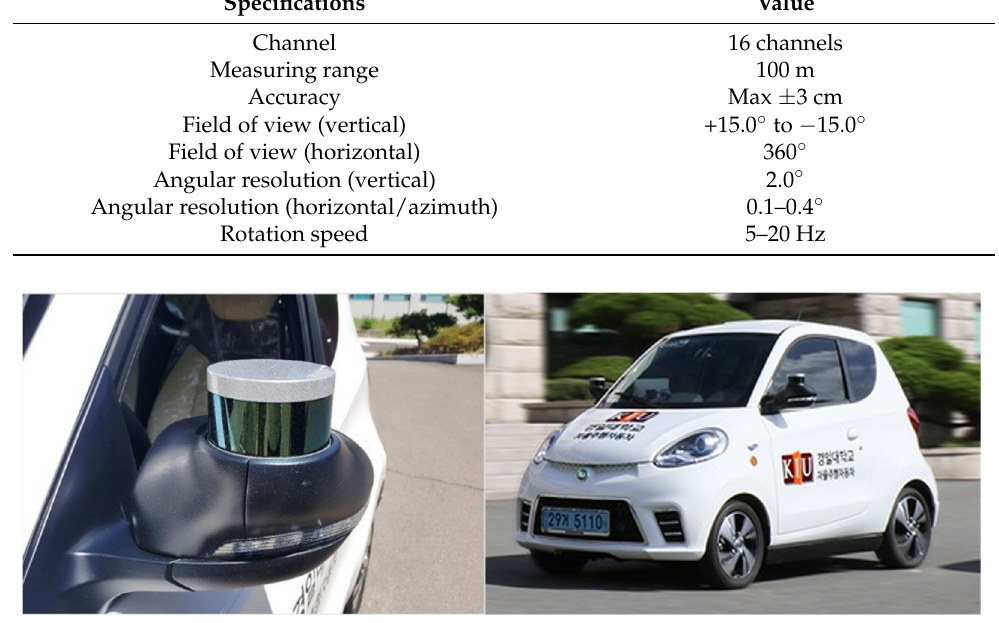
Figure 7. LiDAR sensor on the vehicle. Table 4. Velodyne VLP-16 specifications. Table 5. Constant values of Equations